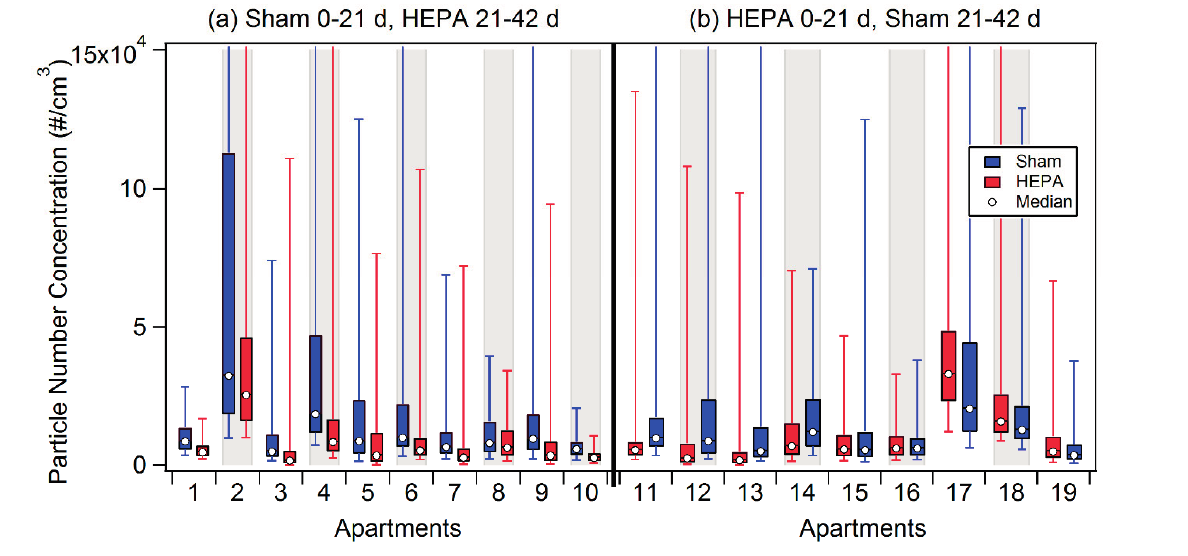
Figure 2. Box plots of all PNC measurements from each participant’s apartment stratified by filter order: ( a ) sham for first 21 days followed by HEPA for last 21 days; ( b ) HEPA for first 21 days followed by sham for last 21 days. The whiskers represent the 5th and 95th percentiles; open circles represent the median PNC values. Note that the apartments are not numbered in chronological order (see Table